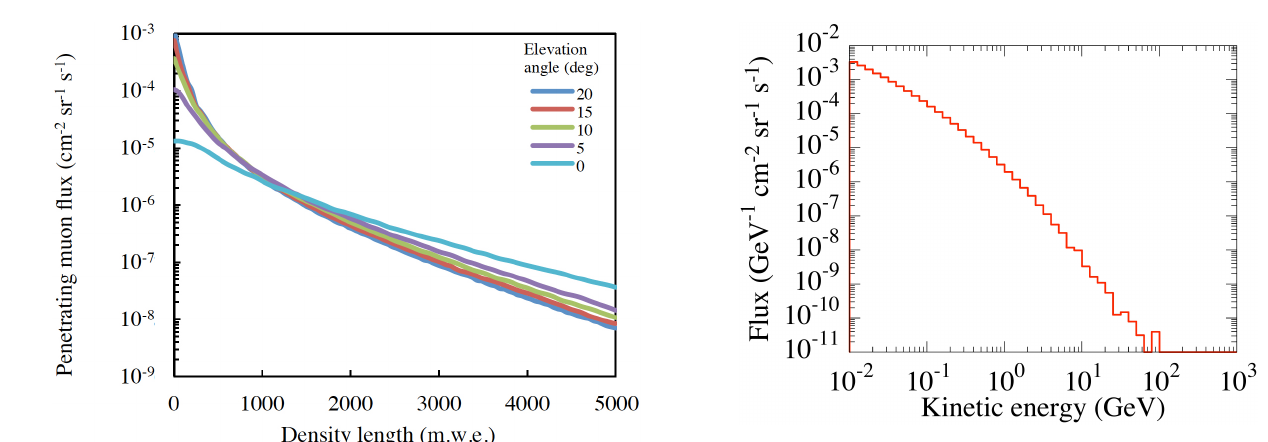
Figure 3. Differential energy spectrum of electromagnetic compo- nents (electron and positron) of secondary cosmic rays at sea level. The arriving angles range between 50 and 90 ◦ from